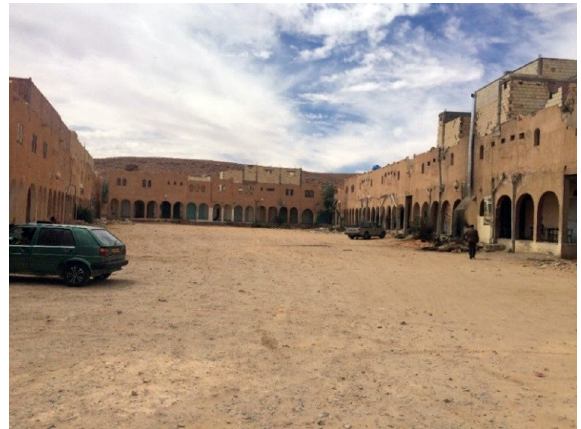
Fig. 6. Place of August 20 of Metlili. Source: Rahmani, May 2018.